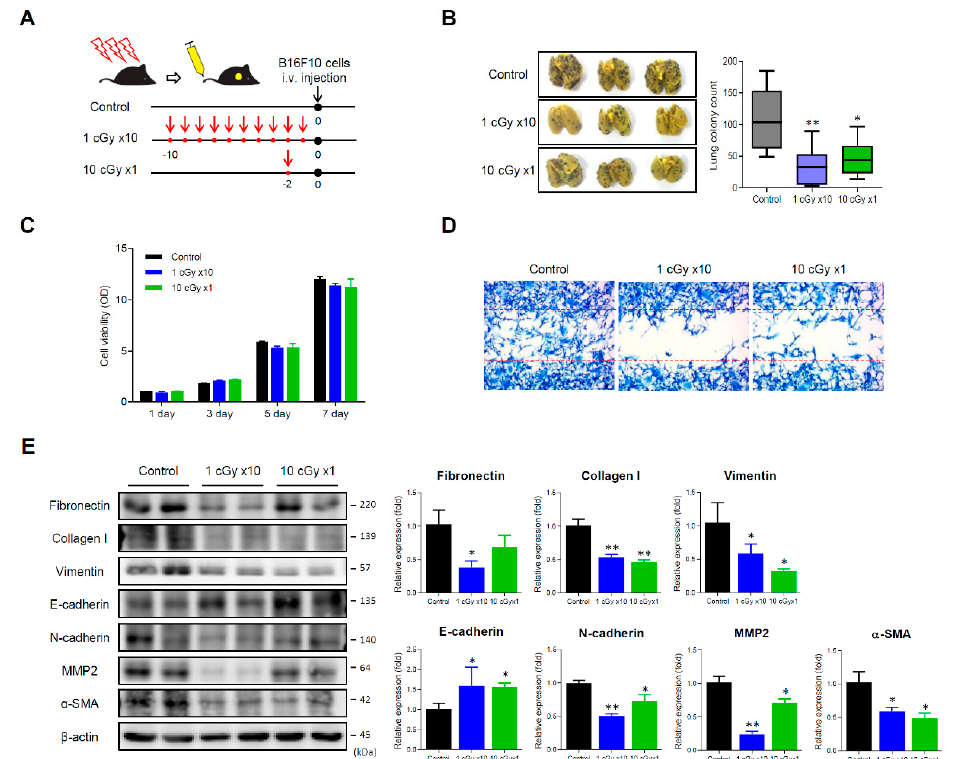
Figure 1. Low dose irradiation (LDI) inhibits the lung metastasis in B16F10 melanoma-bearing